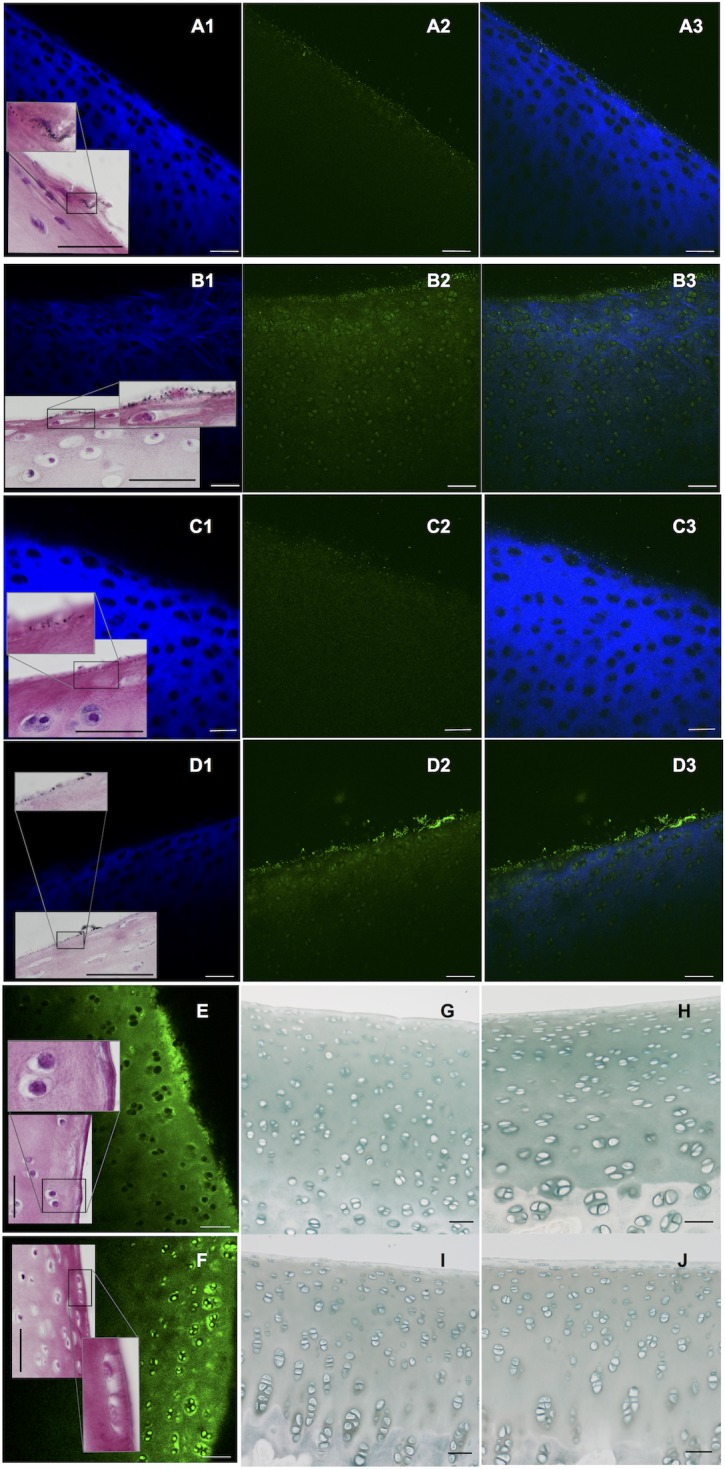
Multiphoton laser scanning and bright field microscopic images post autometallographic enhancement to assess nanoparticle permeation.Panels A-F show axial multiphoton laser scanning microscopic images of conditioned and unconditioned cartilage samples post fluorophore conjugated AuNP or free fluorophore exposure (green channel). Matched histologic images (H&E) post autometallographic particle enhancement provide an alternate method for AuNP-detection (dark signal; bar in panels = 50 μm). Panel A: Unconditioned cartilage exposed to 30 nm fluorophore conjugated nanoparticles. Panel B: Conditioned cartilage exposed to 30 nm fluorophore conjugated nanoparticles. Panel C: Unconditioned cartilage exposed to 80 nm fluorophore conjugated nanoparticles. Panel D: Conditioned cartilage exposed to 80 nm fluorophore conjugated nanoparticles. 1 = Second harmonic generation (SHG) signal in cartilage, representative of collagen content (blue channel). 2 = Nanoparticle bound fluorophore signal (green channel). 3 = Combined fluorophore and SHG signal. Panels E and F: Unconditioned (E) and conditioned (F) cartilage controls exposed to free fluorophore (green channel; matched histology included). Panel G and H: Alcian blue stains of unconditioned samples shown in A and C. Panel I and J: Alcian blue stains of conditioned samples shown in B and D. Superficial cartilage layers are permeable to 30 nm and to a lesser degree 80 nm particles. Conditioning induced GAG and collagen loss, seen here as reduced second harmonic generation imaging signal (blue channel) and loss of Alcian blue staining (Panel I and J). This led to deeper particle permeation and concurrent background staining/outlining of chondrocyte lacunae (Panel A2 vs B2; Panel C2 vs D2). Similarly post conditioning deeper permeation of 30 nm vs 80 nm fluorophore conjugated AuNPs was appreciated (Panel B2 vs D2). Controls exposed to free fluorophore showed marked ECM (Panels E and F) and intracellular fluorophore signal (Panel F), but absence of the very superficial “punctate” signal intensities as observed in Panels A2-D2.